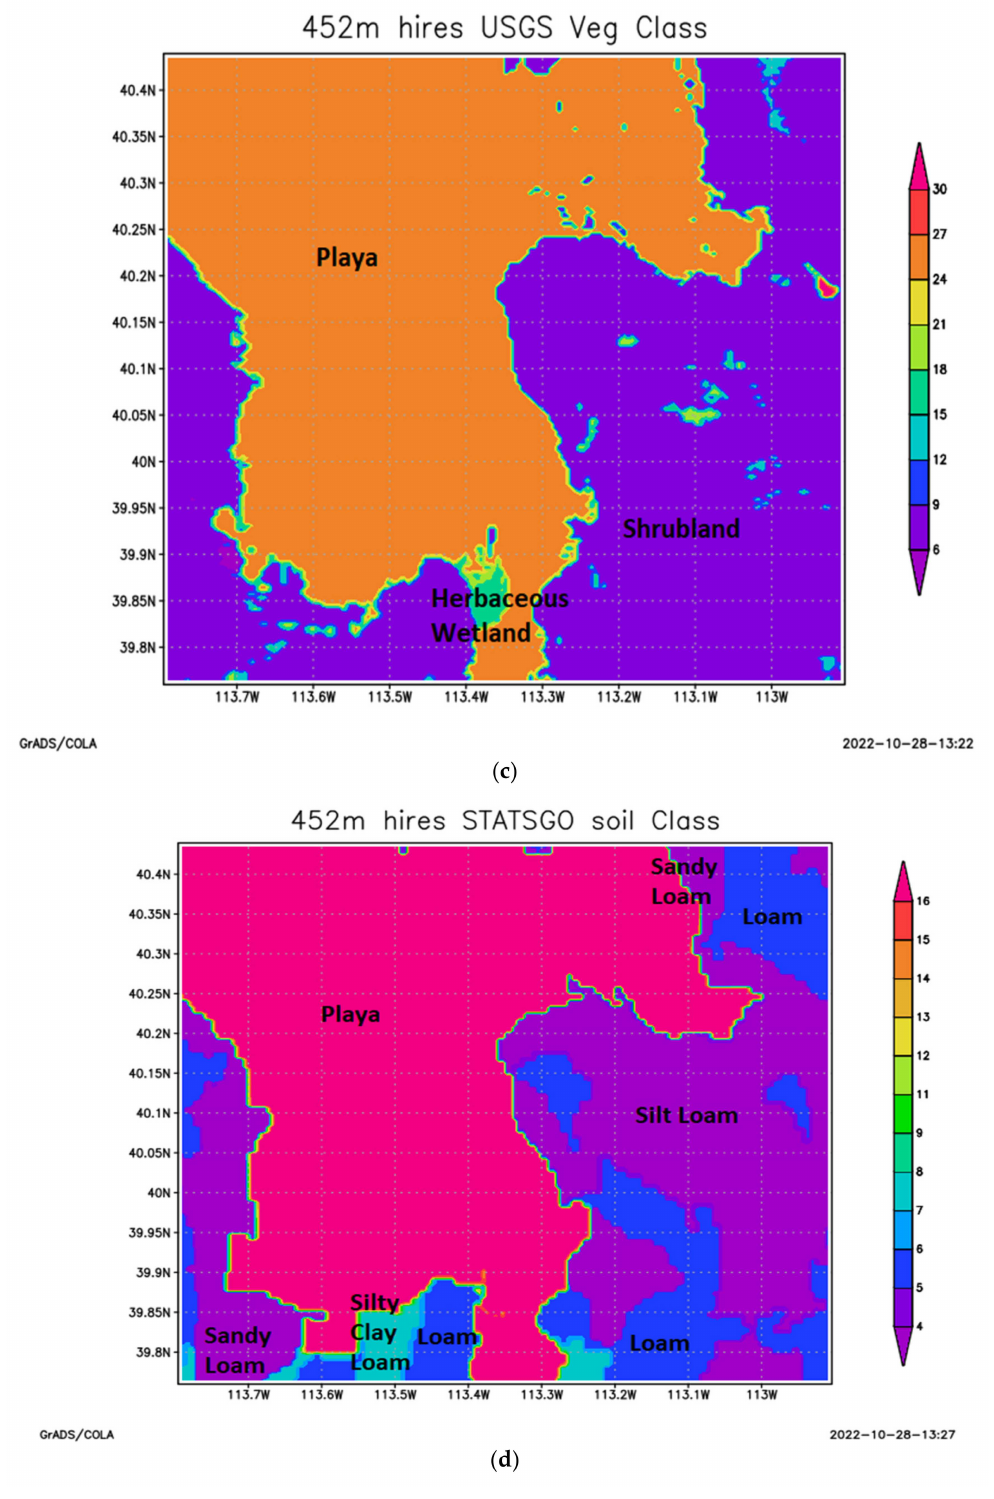
Figure 2. ( a ) Lower resolution land use/vegetation classes used for MS1 for the 452 m grid-spacing inner nest. ( b ) Lower category STATSGO soil-texture classes used for MS1 for the 452 m grid-spacing inner nest. ( c ) Higher resolution land use/vegetation classes used for MS1 for the 452 m grid-spacing inner nest. ( d ) Higher category STATSGO soil-texture classes used for MS1 for the 452 m grid-spacing inner